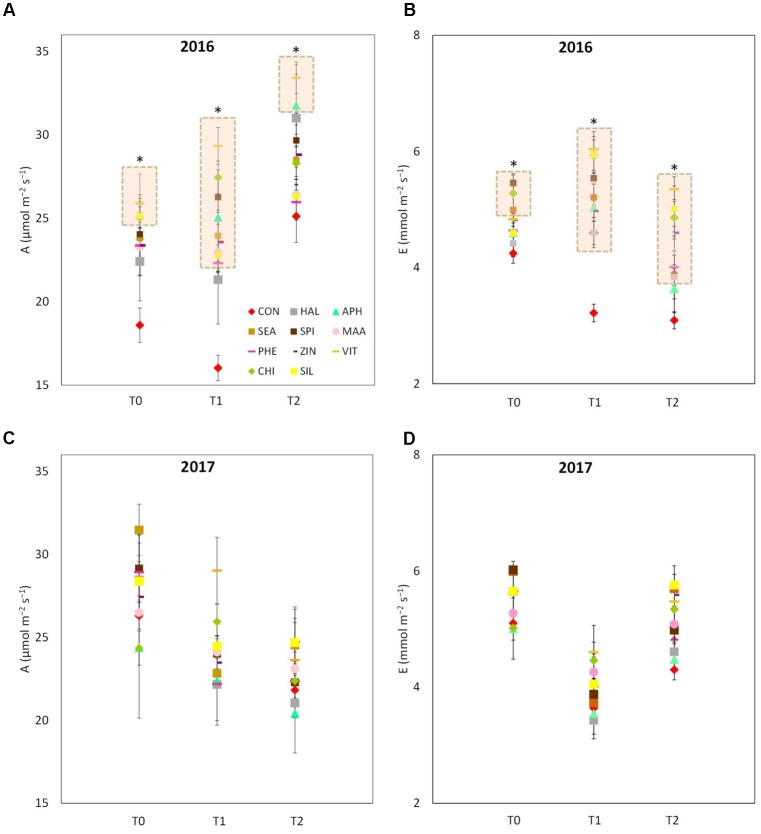
Photosynthetic and transpiration rates measured in 2016 (A,B, respectively) and 2017 (C,D, respectively) as affected by biostimulant applications (T0: immediately before spray; T1: 48 h after spray; T2: 96 h after spray). Asterisk (∗) and the pink rectangle in the background indicate the group of treatments that significantly differed from control according to Dunnett’s test (P < 0.05).